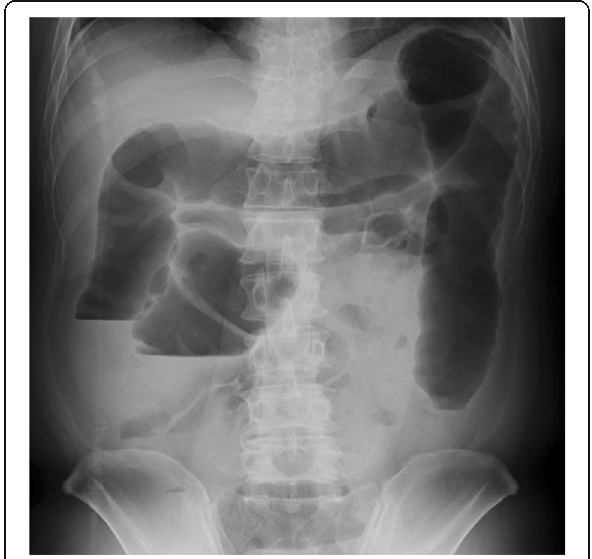
Fig. 5 Abdominal X-ray. Megacolon is evident